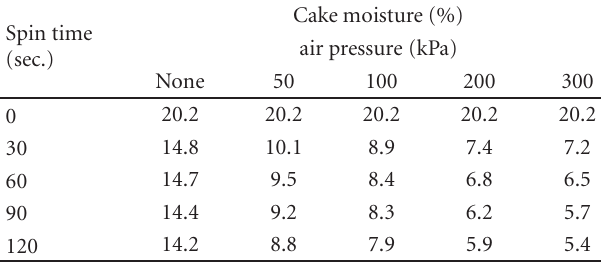
Table 1: E ff ects of G -force and air pressure on the dewatering of sphalerite sample ( − 150 μ m) at 500 G -force and 1.5cm cake